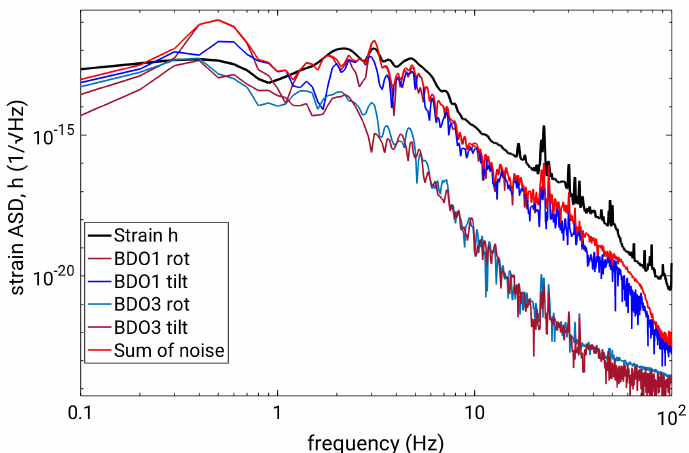
Figure 4. The noise projection of the MDWS feedback signals to h . The rotation of the mirror about the horizontal axis is called tilt and about the vertical axis is called rot. Below 1Hz, h is dominated by the feedback noise but reduces gradually for higher